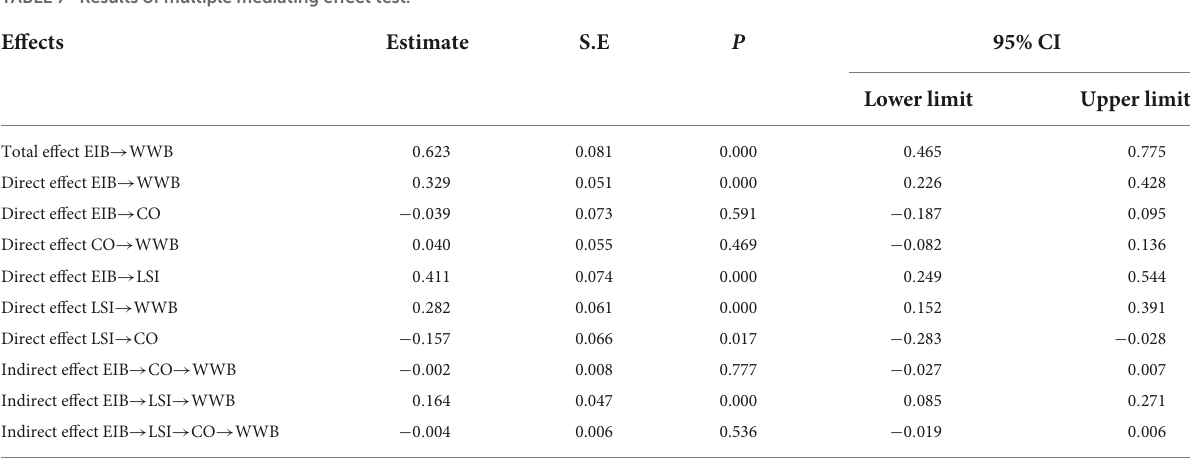
TABLE 7 Results of multiple mediating effect